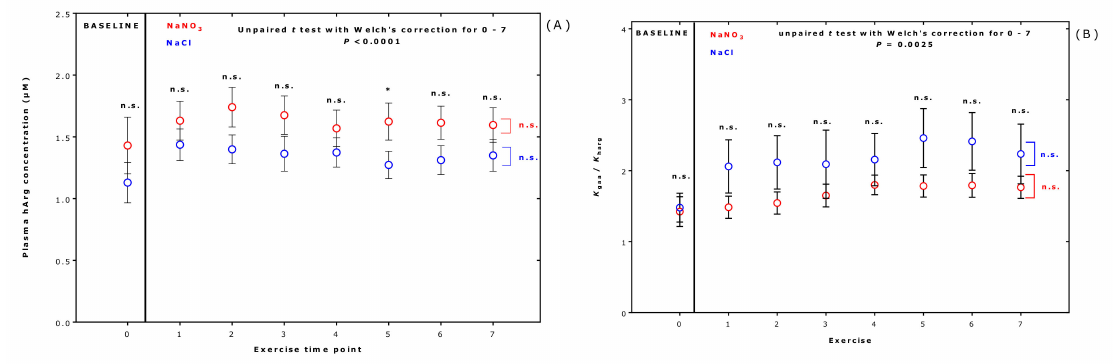
Figure 5. Plasma homoarginine (hArg) concentration ( A ) and K gaa / K harg ( B ) values of the volunteer- ing persons of the NaNO 3 and NaCl groups at baseline (0) and at the seven individual timepoints of exercise after supplementation (see Scheme 2). Data are shown as the mean with standard error of